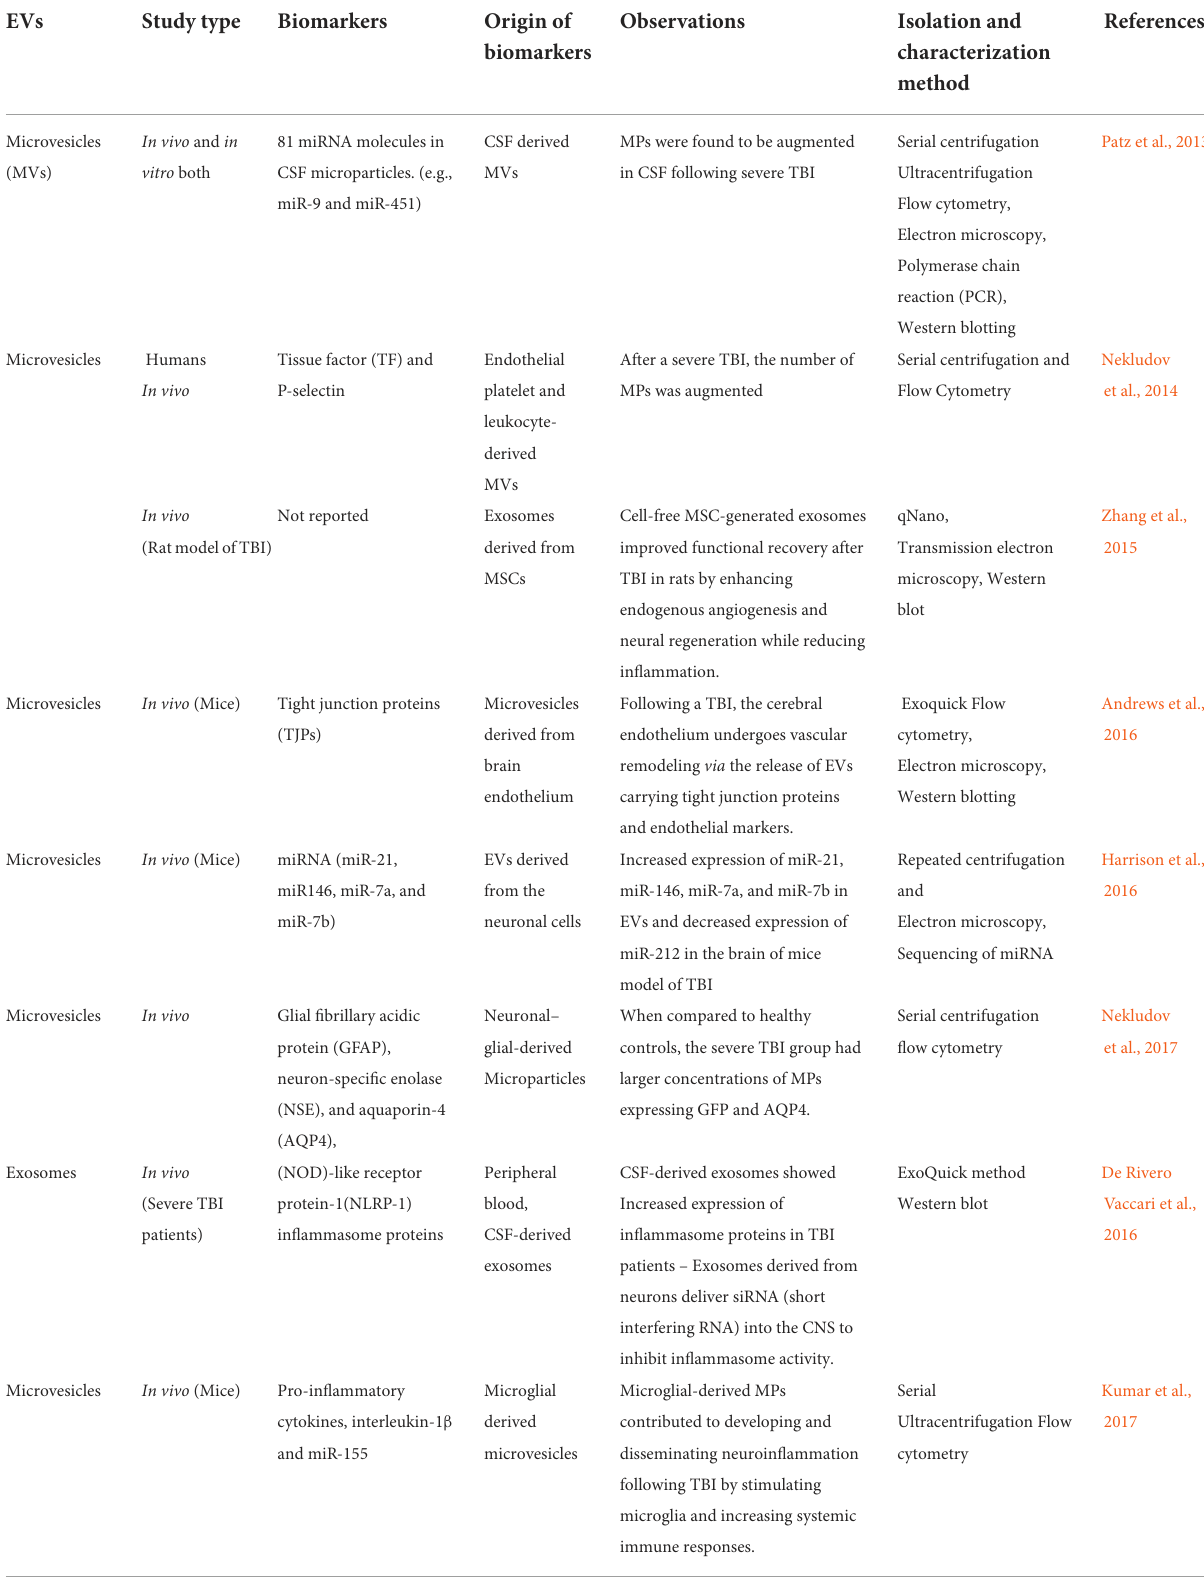
TABLE 3 Studies related to EVs as biomarkers in